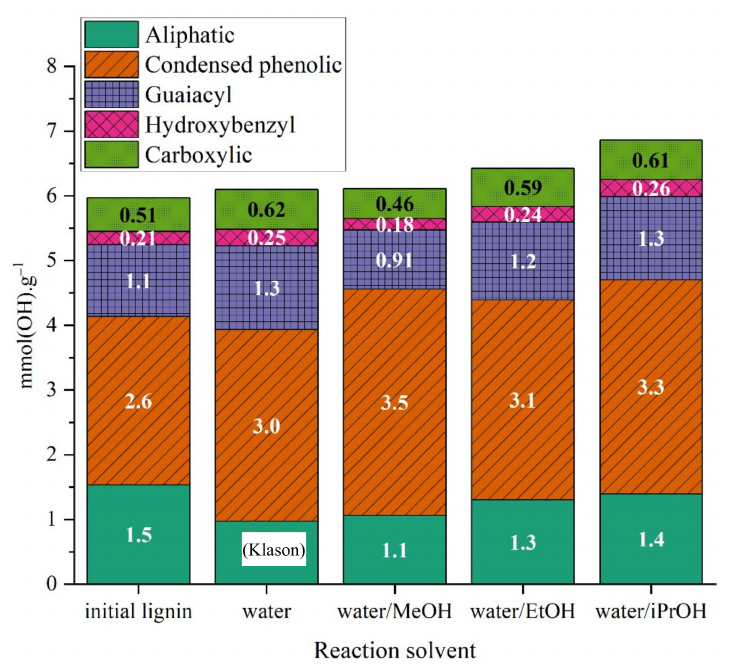
Figure 14. Concentration of -OH groups in Klason phases obtained in different solvent mixtures without